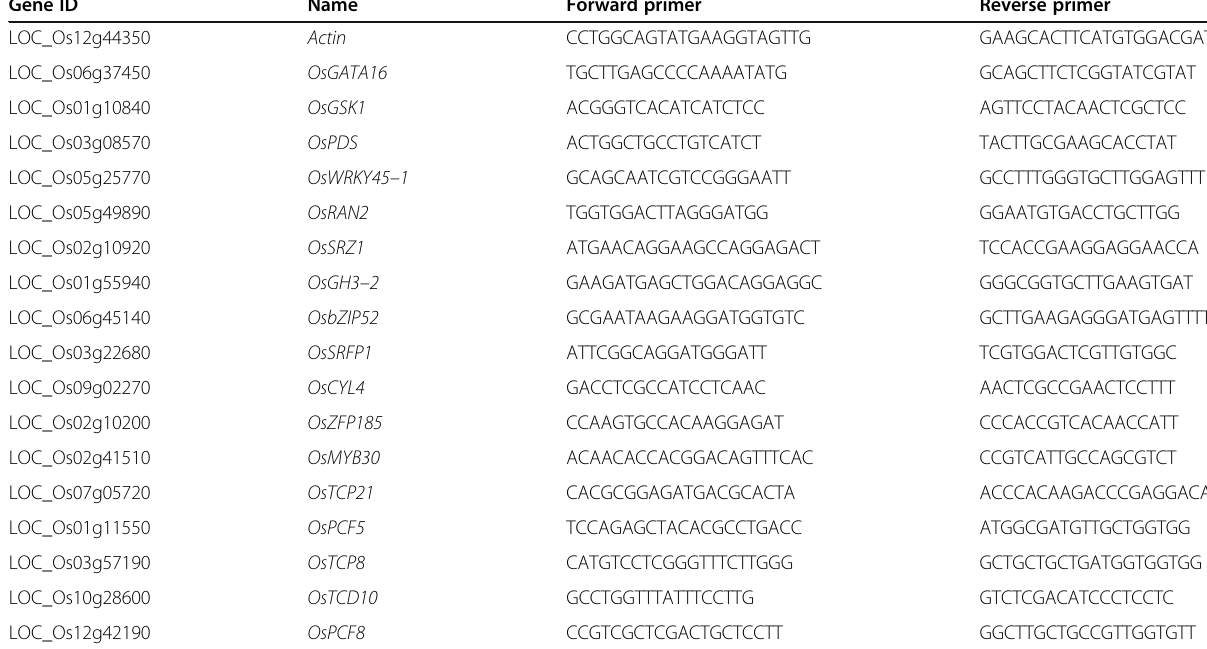
Table 2 Primers for qRT-PCR Gene